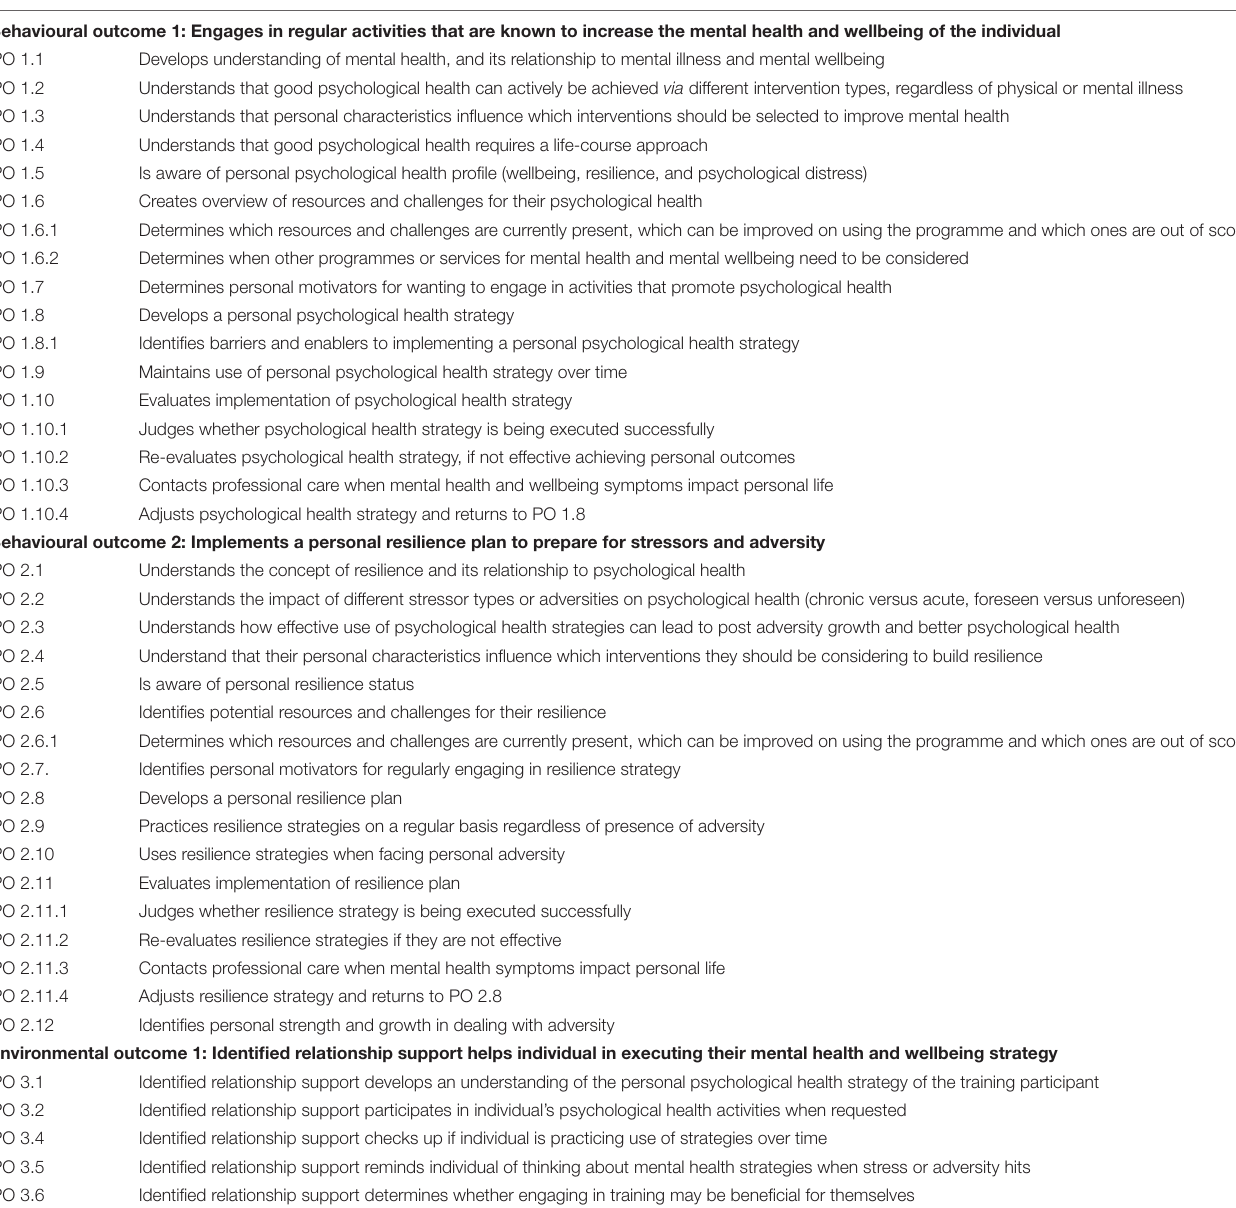
TABLE 1 | Behavioural and environmental outcomes, and performance objectives (PO) for Complete Mental Health. Behavioural outcome 1: Engages in regular activities that are known to increase the mental health and wellbeing of the